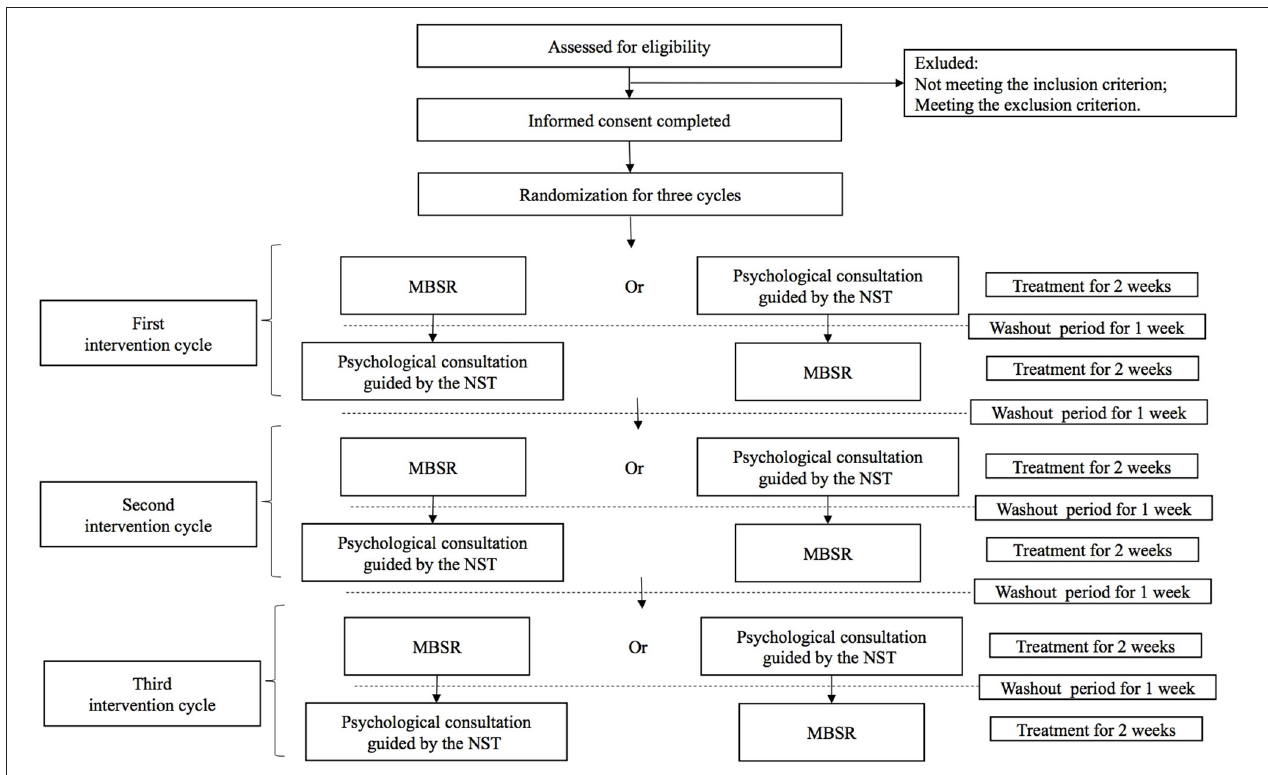
FIGURE 1 | The flowchart of the study